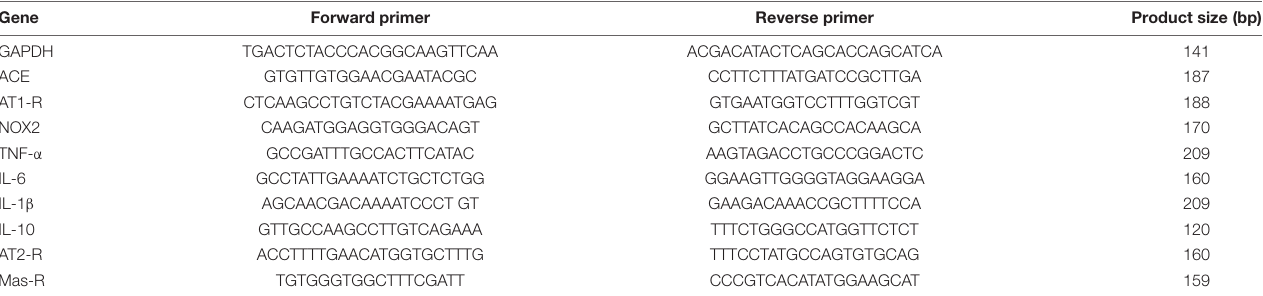
TABLE 1 | Primer sequences for real time